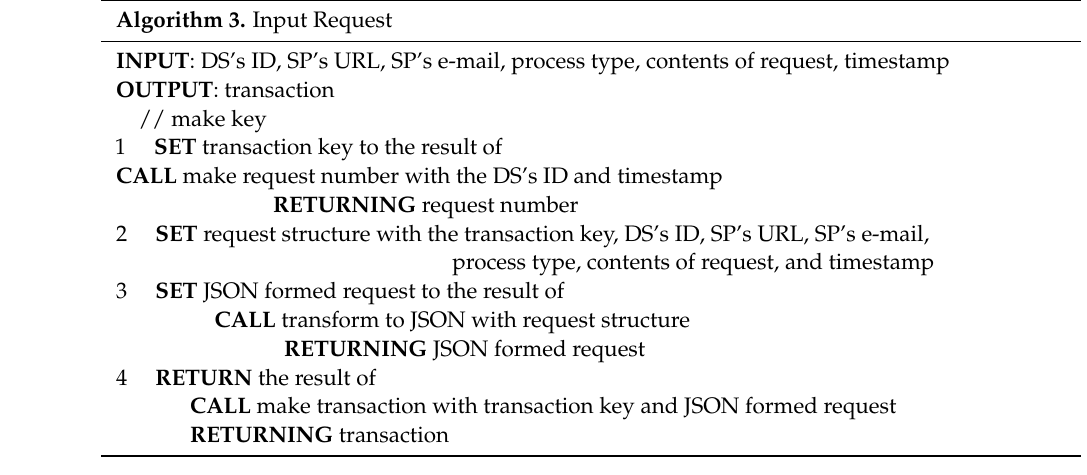
Algorithm 4 is the algorithm for the smart contract implement of response registration in Figure 8. Algorithm 4. Input